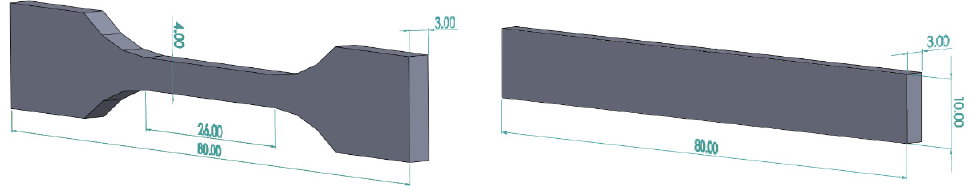
Figure 2. Schematic drawings of the tensile test specimen and notched Izod impact test specimen. The dimensions are given in mm.